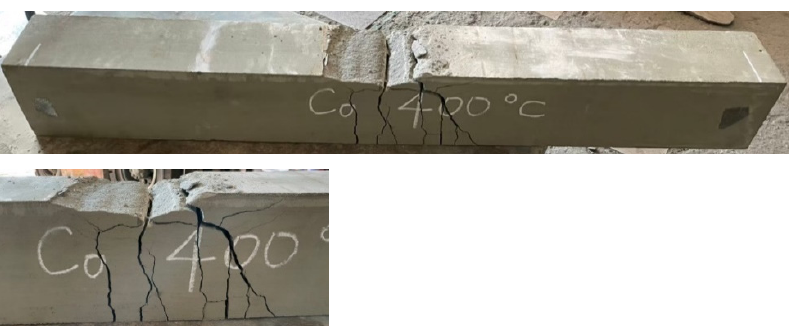
Figure 12. The fracture situation of the experimental group after being subjected to 400 °C.